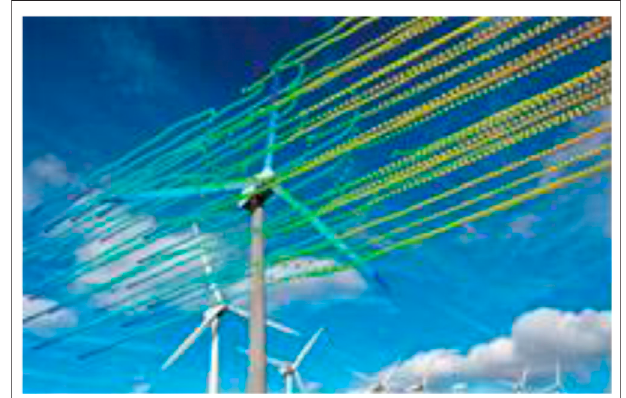
FIGURE 1 | The wind wheel turns the interference simulation of the air fl ow.